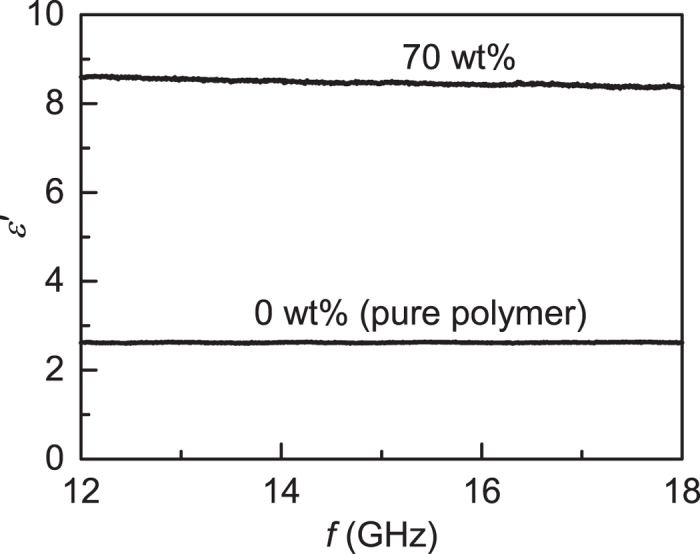
Real part of the permittivity ε′ as a function of frequency for ABS polymer only and 70 wt% BaTiO3/ABS polymer composite.